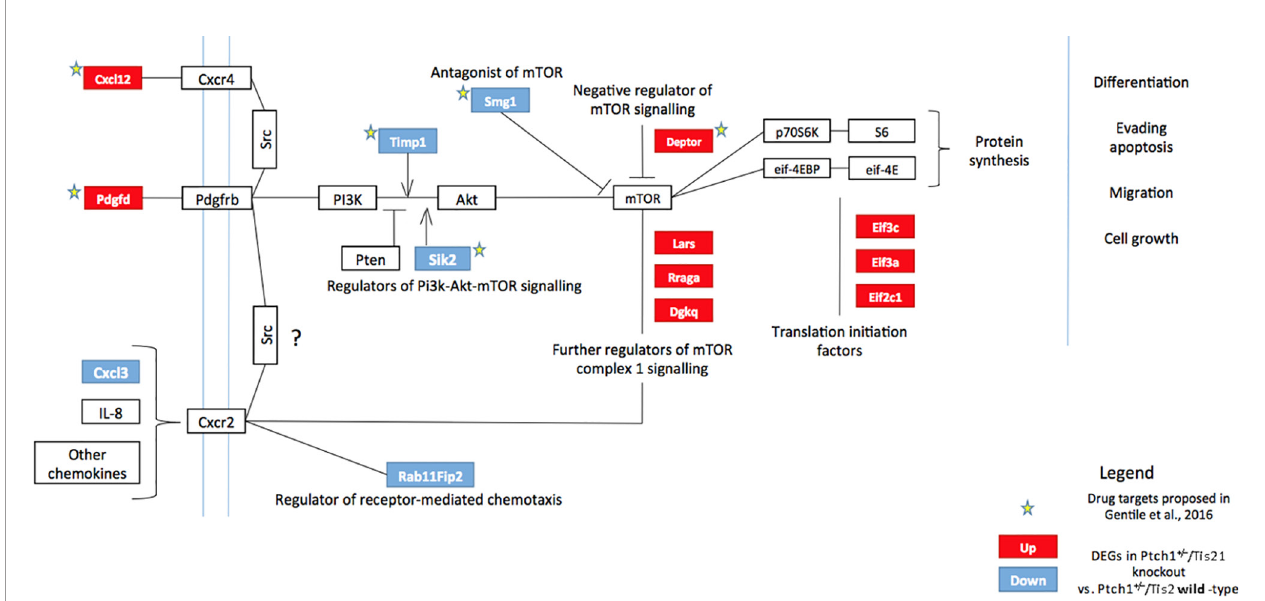
FIGURE 1 | High frequency MB mouse model Ptch1 +/ − /Tis21 KO has a speci fi c activation signature of the PI3K/AKT/mTOR pathway. The picture shows the main components of the PI3K/AKT/mTOR pathway, chie fl y involved in cell growth, differentiation, migration and survival. Signaling is activated at the cell membrane by different growth factors and cytokines, and is propagated through PI3K and AKT to a range of downstream molecules, including mTOR, a key regulator of protein synthesis. Several factors may constitutively activate or inhibit this signaling pathway. The colored boxes, blue or red, highlight the genes differentially expressed in the pairwise comparison Ptch1 +/ − /Tis21 KO versus Ptch1 +/ − /Tis21 WT (see Figure 2 ), identi fi ed by microarray analysis of the GCPs isolated from mice at P7, previously performed by us (27). The blue or red colors indicate down-regulated or up-regulated transcriptional expression, respectively. In Ptch1 +/ − /Tis21 KO cells there is a model-speci fi c activation of the PI3K/AKT/mTOR pathway, with extensive deregulation of the mRNA expression of upstream regulators as well as of the downstream targets. Arrows represent activation; bars represent inhibition. The stars indicate the potential drug targets, identi fi ed through the genomic analysis of deregulated Ptch1 +/ − /Tis21 KO -dependent genes, as previously proposed (32). AKT, AKR mouse thymoma kinase; Cxcl, C-X-C motif chemokine ligand; Cxcr, C-X-C motif chemokine receptor; Deptor, DEP domain-containing mTOR-interacting protein; Dgkq, diacylglycerol kinase theta; Eif, eukaryotic translation initiation factor; eif-4EBP, eukaryotic translation initiation factor 4E-binding protein; IL-8, interleukin 8; Lars, leucyl-tRNA synthetase; mTOR, mammalian target of rapamycin; p70S6K, p70 ribosomal protein S6 kinase; Pdgfd, platelet-derived growth factor D; Pdgfrb, platelet-derived growth factor receptor beta; PI3K, phosphatidylinositol-3-kinase; PTEN, phosphatase and tensin homolog; Rab11Fip2, Ras-related binding protein 11 family-interacting protein 2; Rraga, Ras-related GTP-binding protein A; S6, ribosomal protein S6; Sik2, salt-inducible kinase 2; Smg1, nonsense-mediated mRNA decay-associated PI3K-related kinase; Src, steroid receptor coactivator; Timp1, tissue inhibitor of